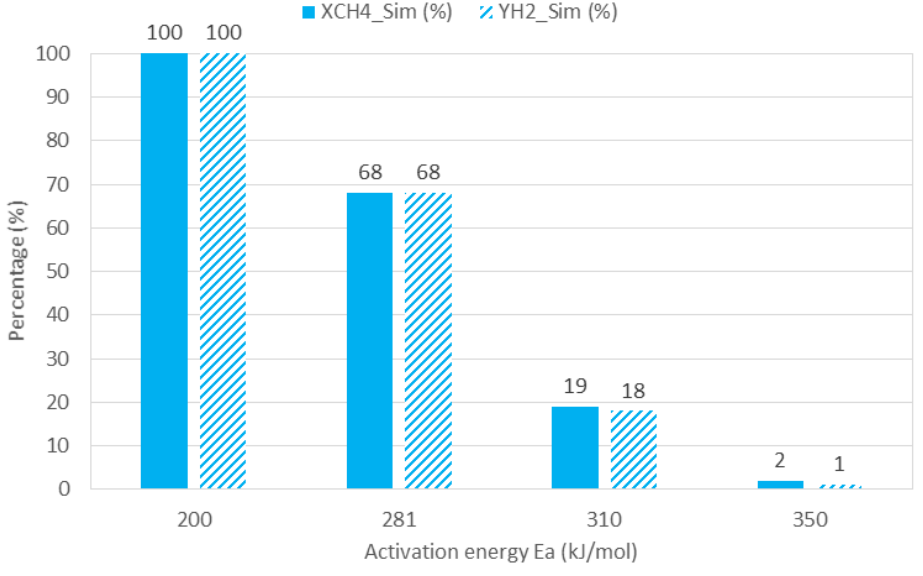
Figure 6. CFD results sensitivity to different values of activation energy.